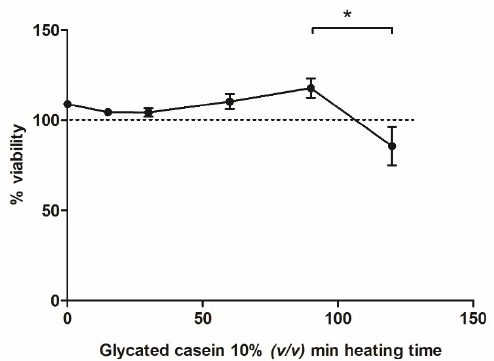
Figure 4. Cell viability of human macrophage-like cells after 6 h exposure to glycated casein from different heating time points (10% v/v ), measured by the MTT assay. Results were normalized to control (50% v/v DPBS), which was set to 100% (dotted line). Data are presented as mean ± SD, n = 4, * = p < 0.05.